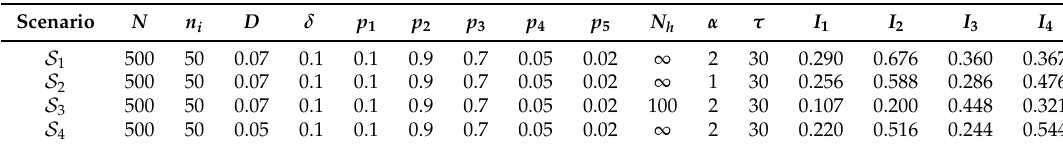
Table 1. Numerical values of the EED parameters for scenarios S i , i = 1, . . . ,4, and the cost indices I j , j = 1, . . .